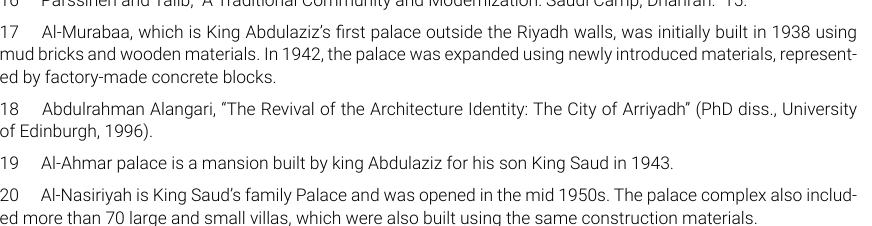
Permanent houses in Dhahran Saudi camp before and during demolition in the early 1980s. Source: Photograph by Kaizir Talib, included in Jon Parssinen and Kaizir Talib, “A Traditional Community and Modernization: Saudi Camp, Dhahran,” JAE 35, no.3